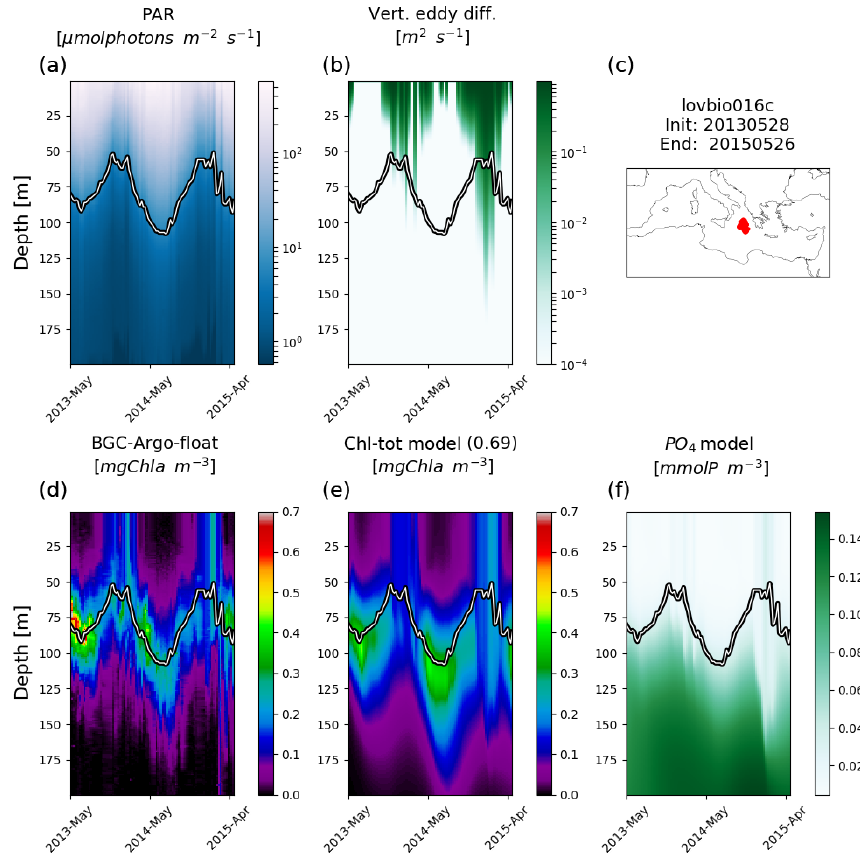
Figure 5. As Fig. 3 but for BGC-Argo float lovbio016c (WMO code 6901510).